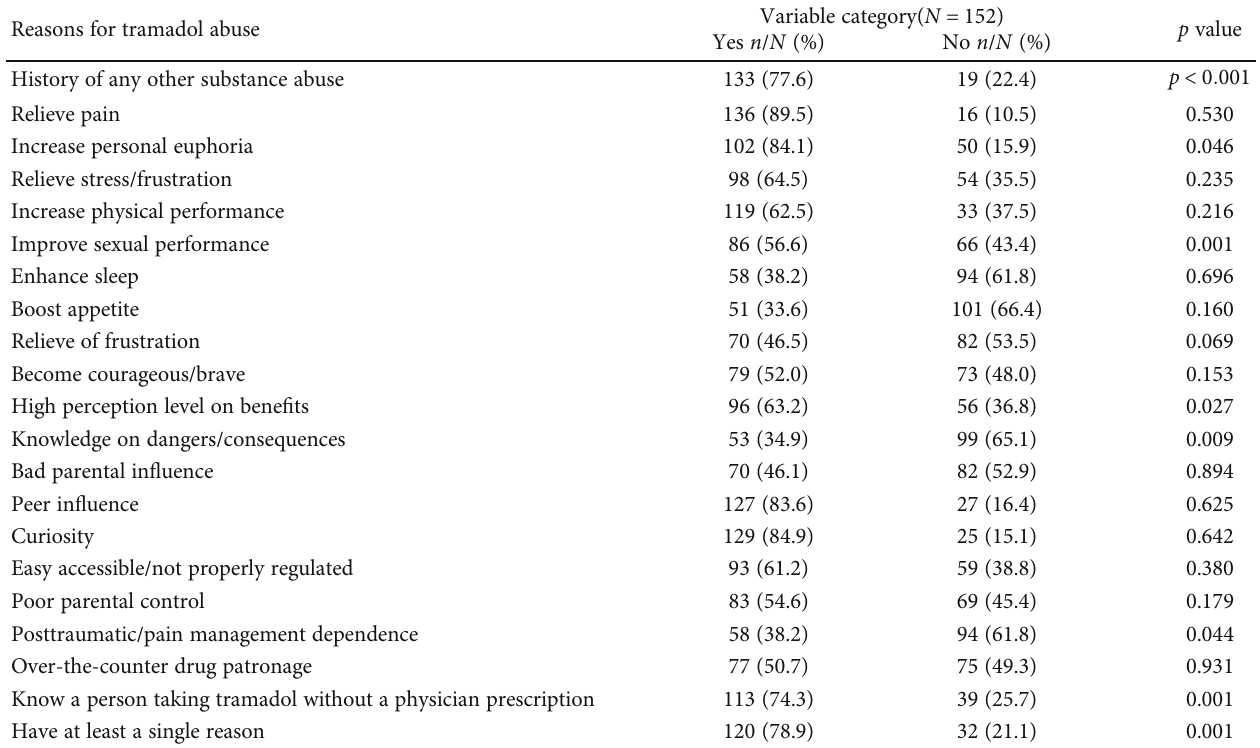
Table 7: Other factors associated with tramadol abuse.